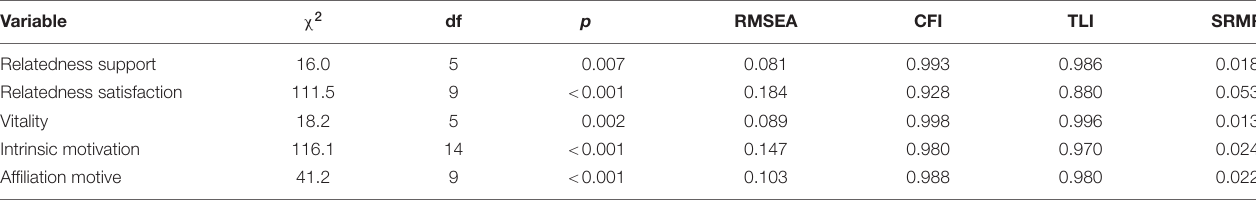
TABLE 1 | CFA model fit indices for each scale.